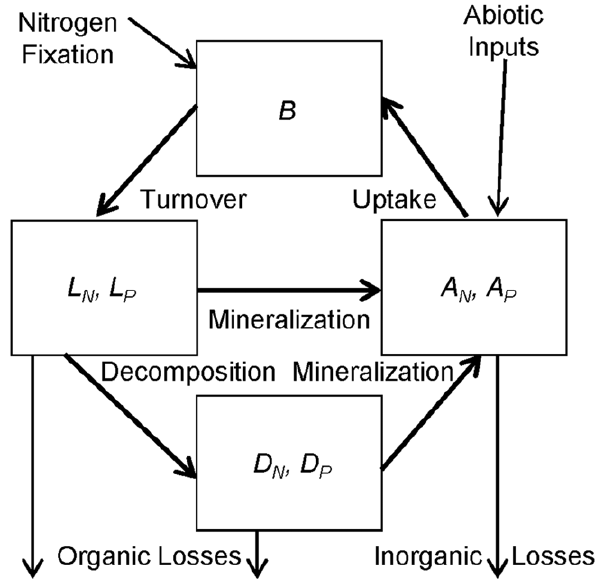
Figure 1. Model ecosystem described in equations 1–7. Living plant biomass ( B ) contains carbon, nitrogen (N), and phosphorus (P) in a fixed stoichiometric ratio. When plant biomass turns over it becomes litter. The model keeps track of litter N ( L N ) and P ( L P ) separately. Some litter is decomposed into plant-unavailable soil organic matter (SOM; D N , D P ), some is mineralized to plant-available soil nutrients ( A N , A P ), and some is lost from the system. Some SOM is mineralized into plant- available nutrients, and some is lost. Plant-available nutrients come from mineralization and external inputs, are taken up by plants, and are lost from the ecosystem. Symbiotic N fixation enters directly into the plant pool. We use ‘‘mineralization’’ as shorthand for ‘‘mineralization and depolymerization’’ to indicate the conversion of nutrient to plant- available form, which can include some organic forms.